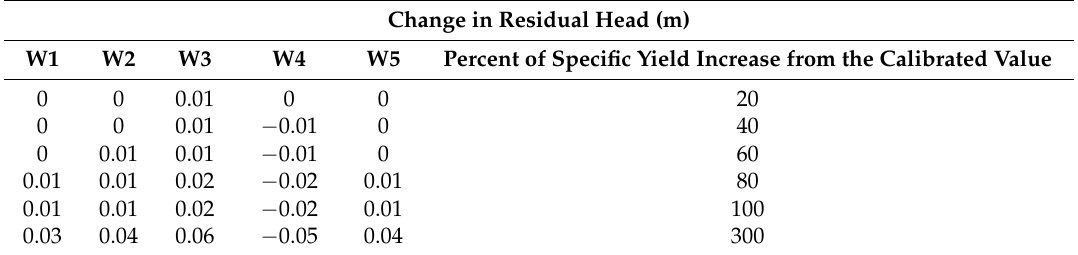
Table 5. Change in head at piezometers W1 to W5 due to changing specific yield (Scenario 5) in comparison to the baseline calibrated specific yield of